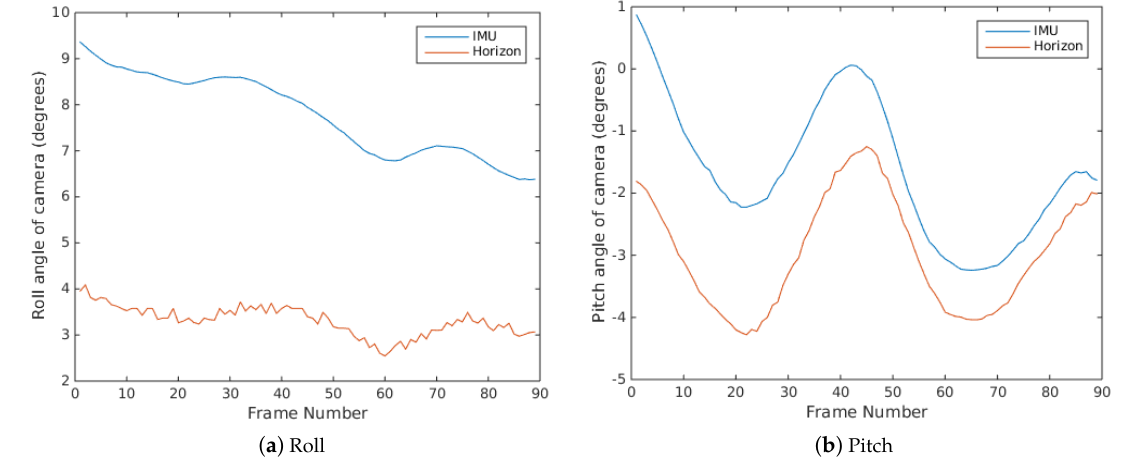
Figure 5. Roll and pitch angles of camera obtained from the IMU and horizon